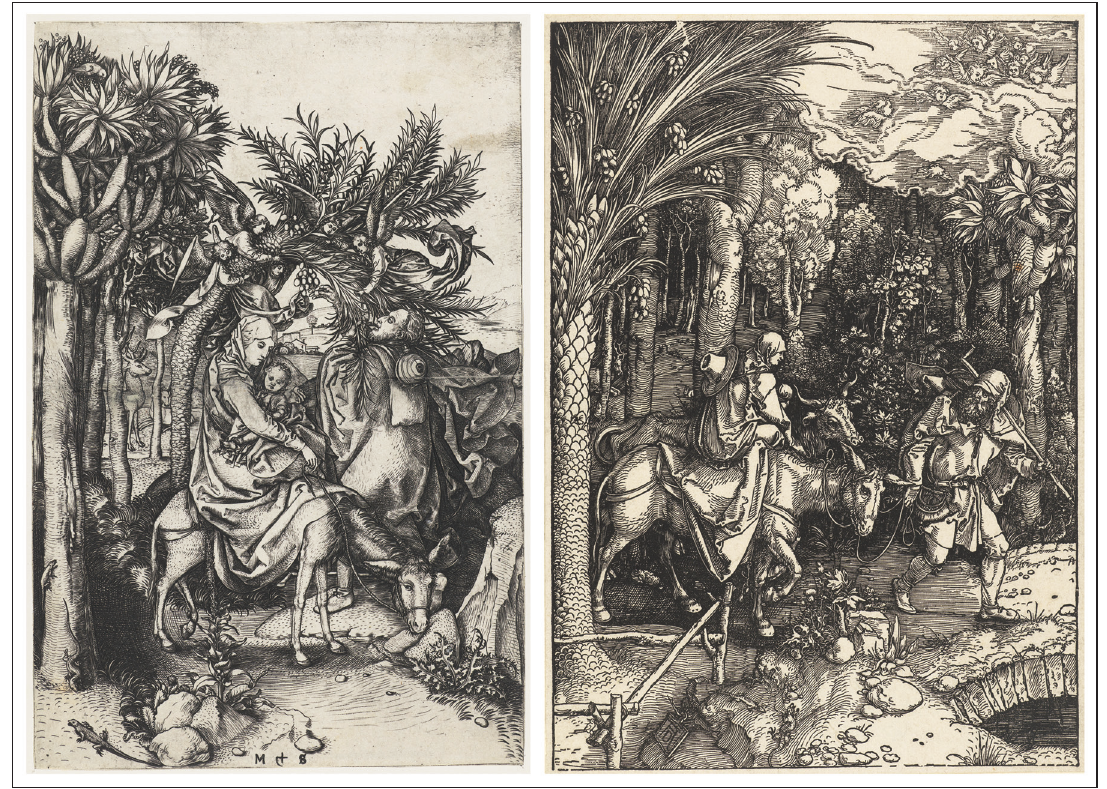
Figure 3: Right: Albrecht Dürer, The Flight into Egypt , 1511, woodcut, printed on paper, 29.6 × 21 cm. Left: Martin Schongauer, The Flight into Egypt , ca. 1470–90, engraving, printed on paper, 25.5 × 16.9 cm. © Rijksmuseum,